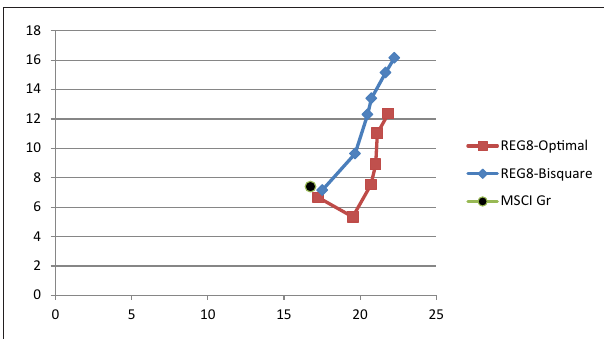
FIGURE 1 | Risk-return portfolios for Beaton-Tukey regressions, 2005–2014.